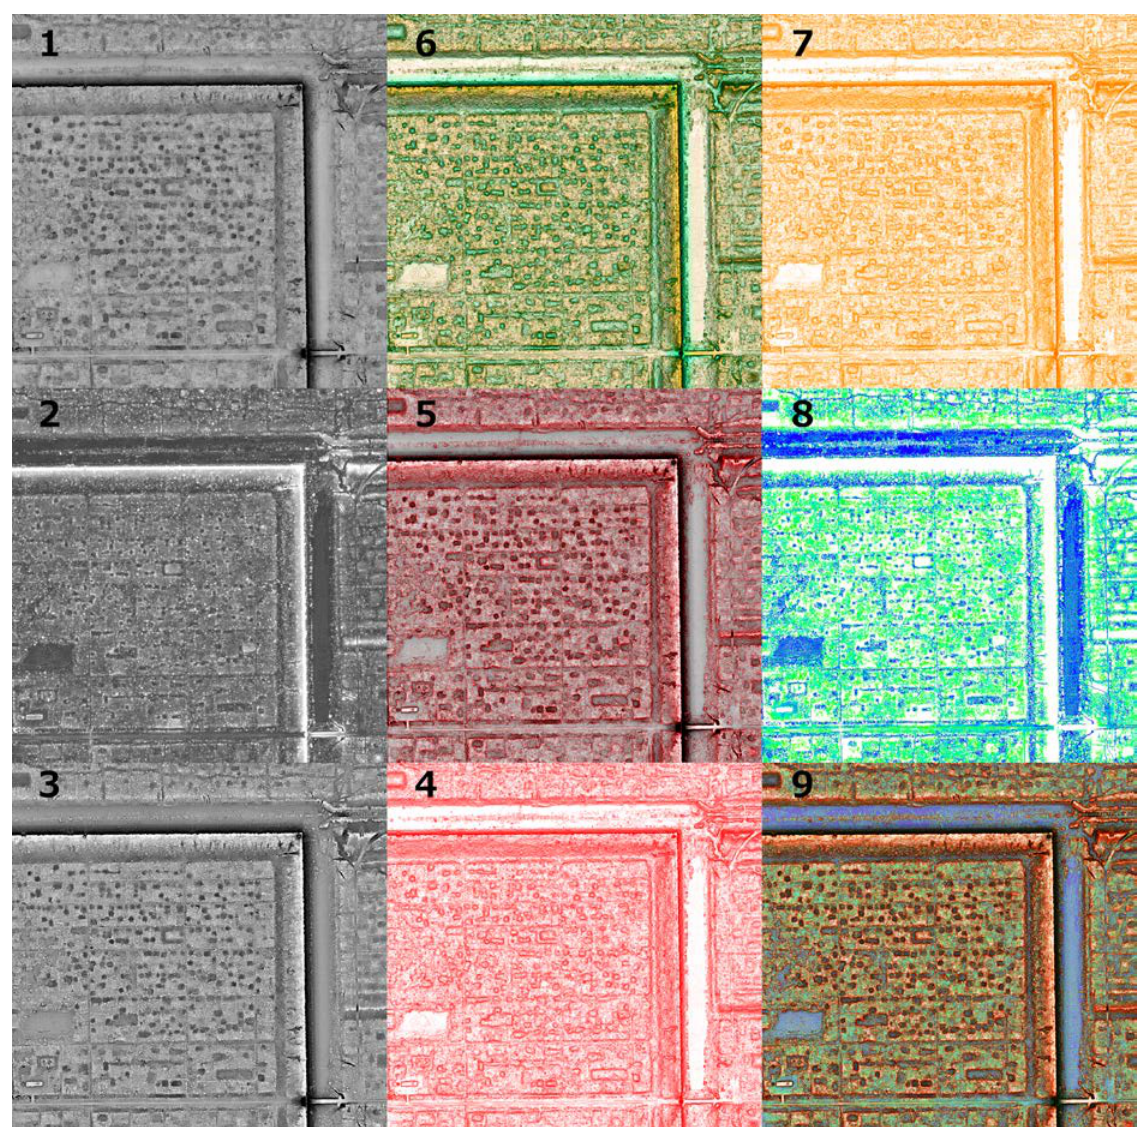
Figure 6. Various images required to making Red Relief Image Map. 1: positive openness map with bright as higher value of positive openness, 2: negative openness map with bright as lower value of negative openness, 3:ridge and valley map with bright as higher RV parameter. The convex range is bright and concave range is dark (3=1+2), 4:red colored slope angle , redder as the gradient becomes steeper, 5:”Red Relief Image Map”(5=3+4), 6: CIE-L*a*b* colored type of RRIM(6=1*3*4), 7:yellow colored slope angle, 8: rainbow-colored negative openness, bluer as the gradient becomes higher value of negative openess ,9:Red Relief Image Map (MANDARA type )with rainbow colored negative